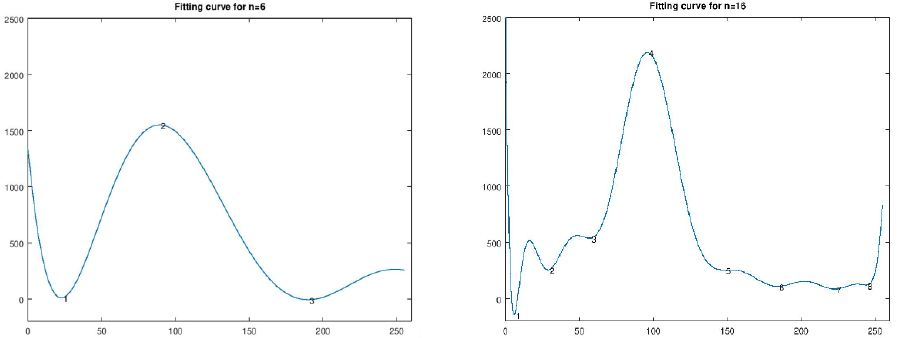
Figure 28. Method 1: Left: fitting polynomial of degree n = 6; right, fitting polynomial of degree n = 16 producing multiple valleys.